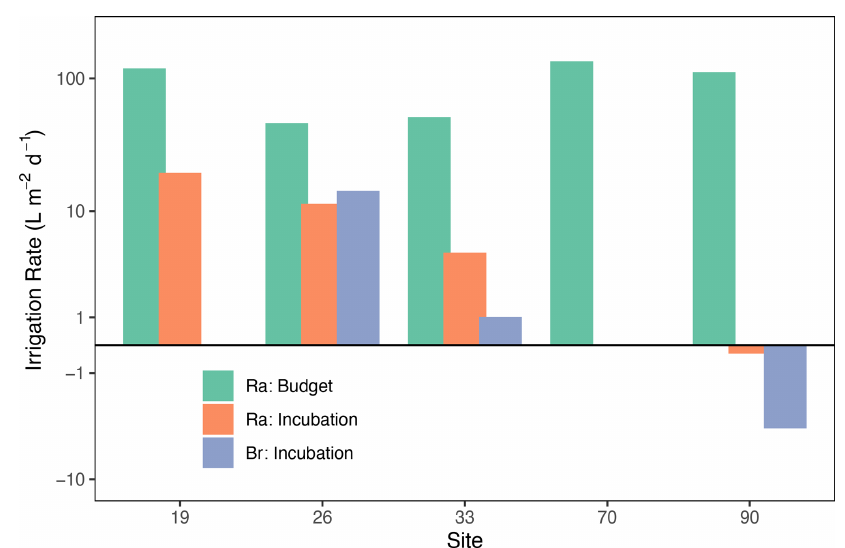
Figure 2. Porewater irrigation rates (Lm − 2 d − 1 ) for the North Sea only, derived from Ra budget (green) and incubations with Ra (orange) or bromide (blue) as